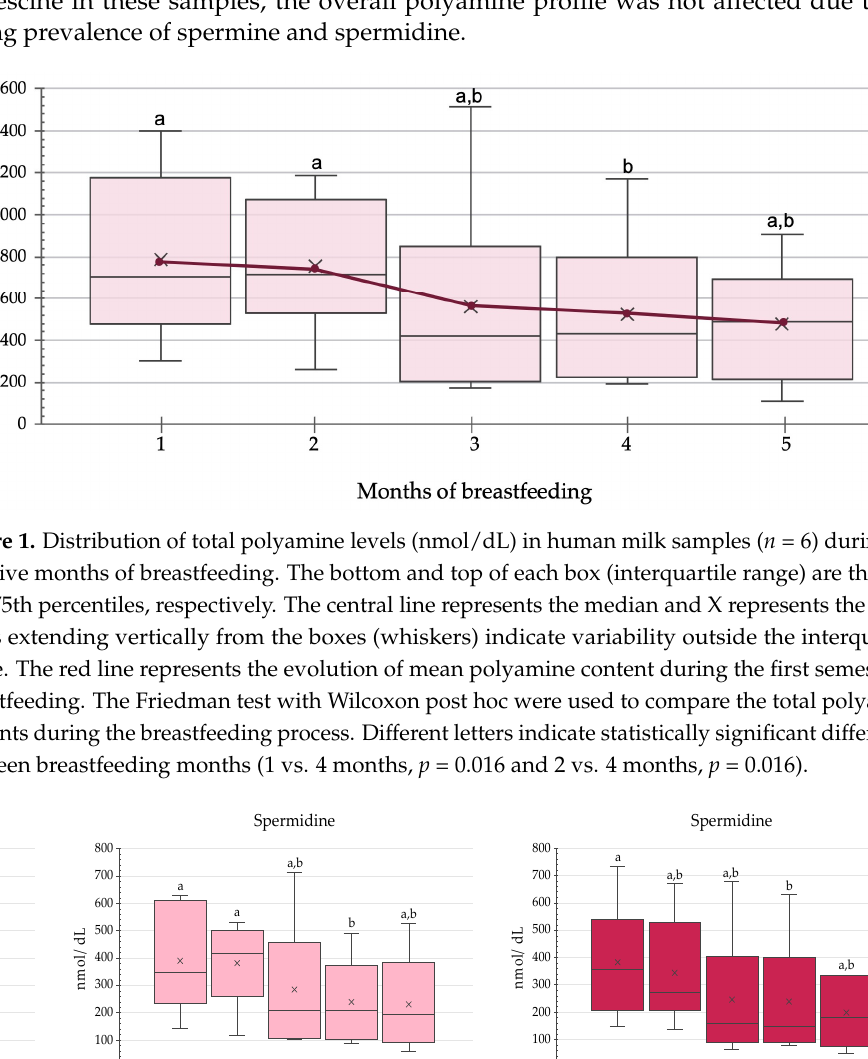
Figure 2. Polyamine levels (nmol/dL) in human milk ( n = 6) during the first five months of breastfeeding. The Friedman test with Wilcoxon post-hoc were used to compare the total polyamine contents during this period. Different letters indicate statistically significant differences between breastfeeding months. For spermidine: 1 vs. 4 months, p = 0.016 and 2 vs. 4 months, p = 0.031. For spermine: 1 vs. 4 months p = 0.016.